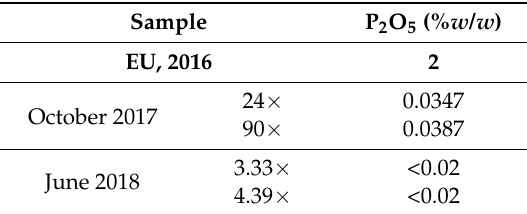
Table 4. Content of P 2 O 5 in concentrated leachates.